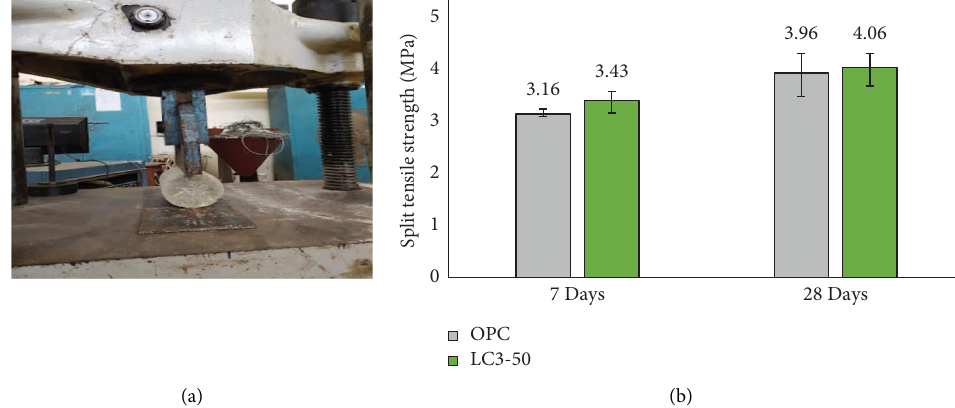
Figure 3: Results of the splitting tensile strength test of concrete samples cast from OPC and LC 3 -50. (a) Split tensile strength test of the cylinder. (b) LC 3 -50 shows more split tensile strength than OPC on 7 and 28days.